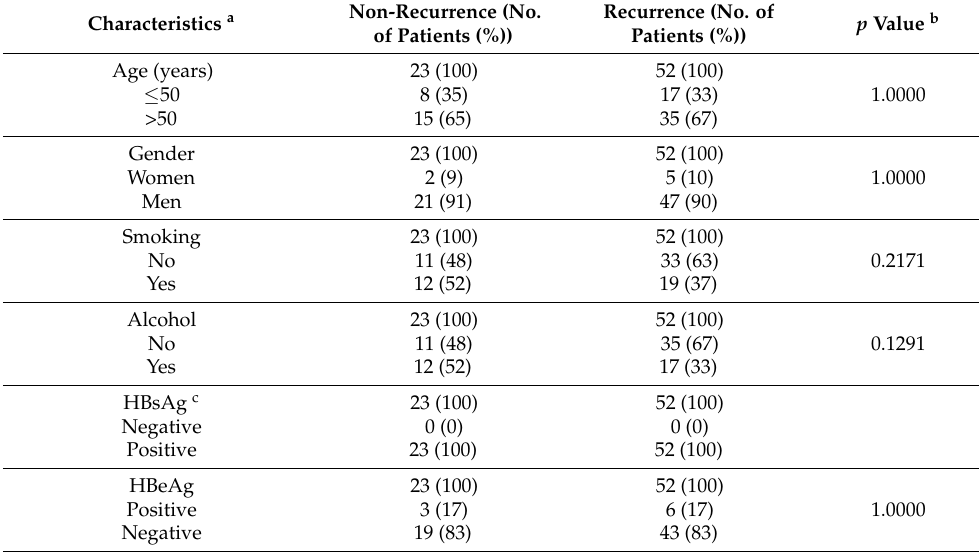
Table 2. Clinicopathological association of HCC recurrence in 75 HBV-related HCC patients af- ter